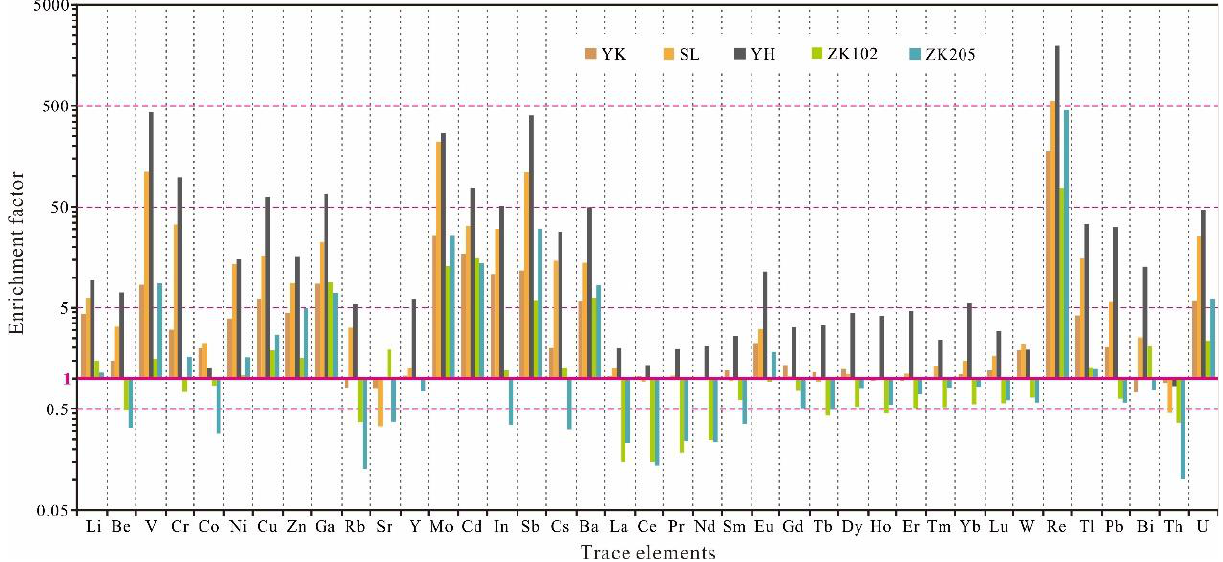
Figure 3. The average enrichment factors of trace elements in the Early Cambrian black shale.